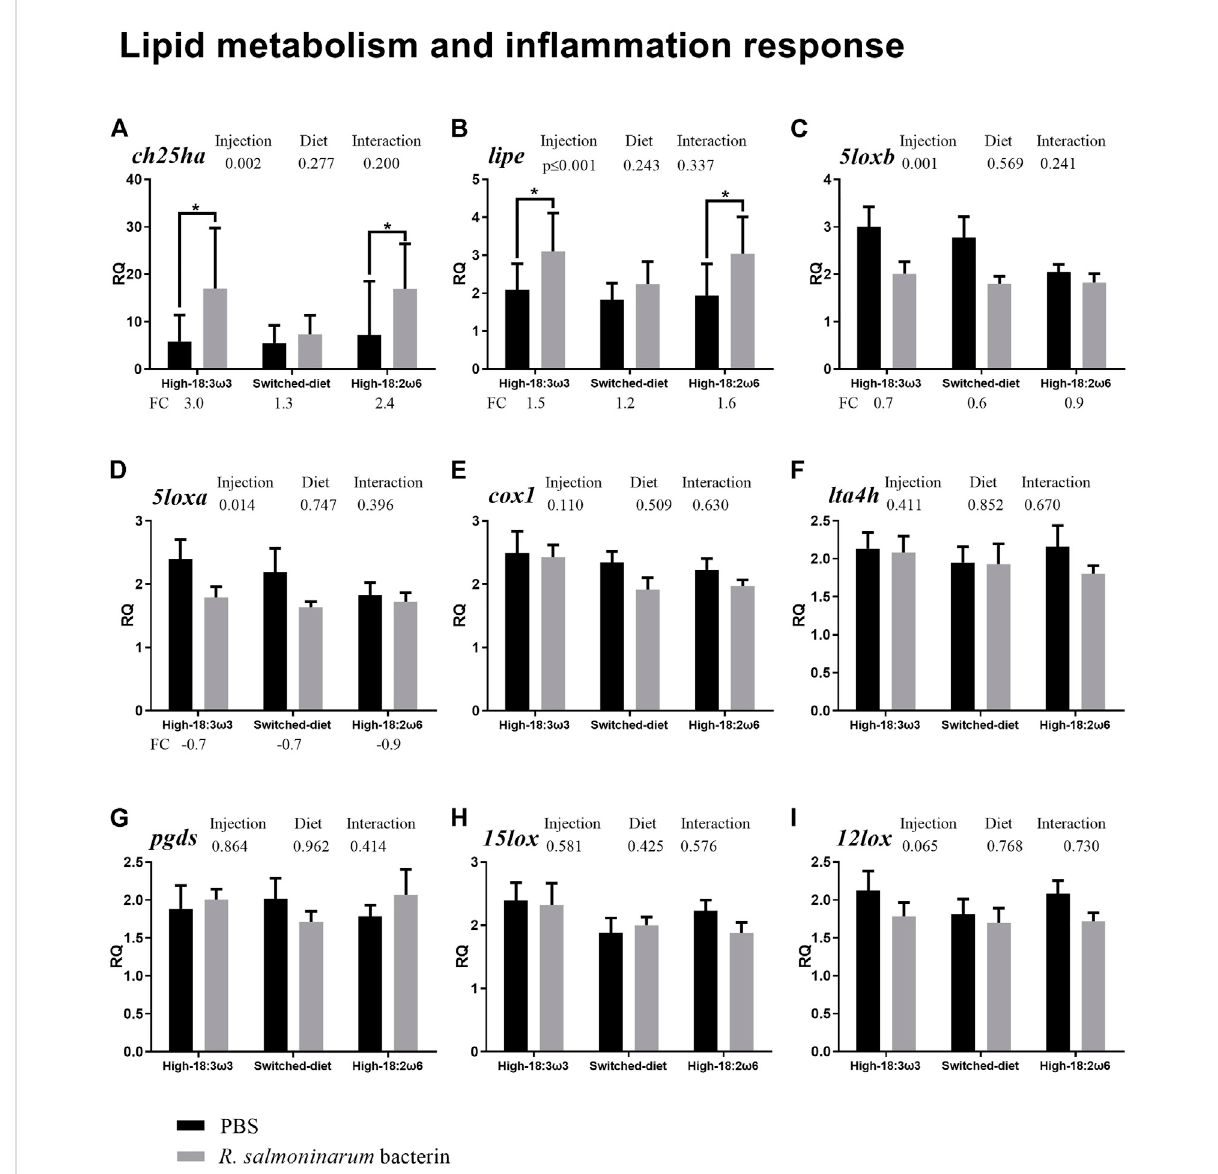
FIGURE 2 qPCR for transcripts playing roles related to lipid metabolism and in fl ammation ( (A – I) ; individual RQs used in the analysis n = 9). Two-way ANOVA results are shown in the table above each panel, and t -test results (i.e., signi fi cant differences between PBS and bacterin-stimulated fi sh withinadietgroup)areshownwithasterisks( “ * ” for p ≤ 0.05).Dataarepresentedasmean±SE.Overallfold-changevalues(FC;meanRQinbacterin- injected group/mean RQ in PBS-injected group) are shown below the transcripts with signi fi cant differences betweengroups. The signi fi